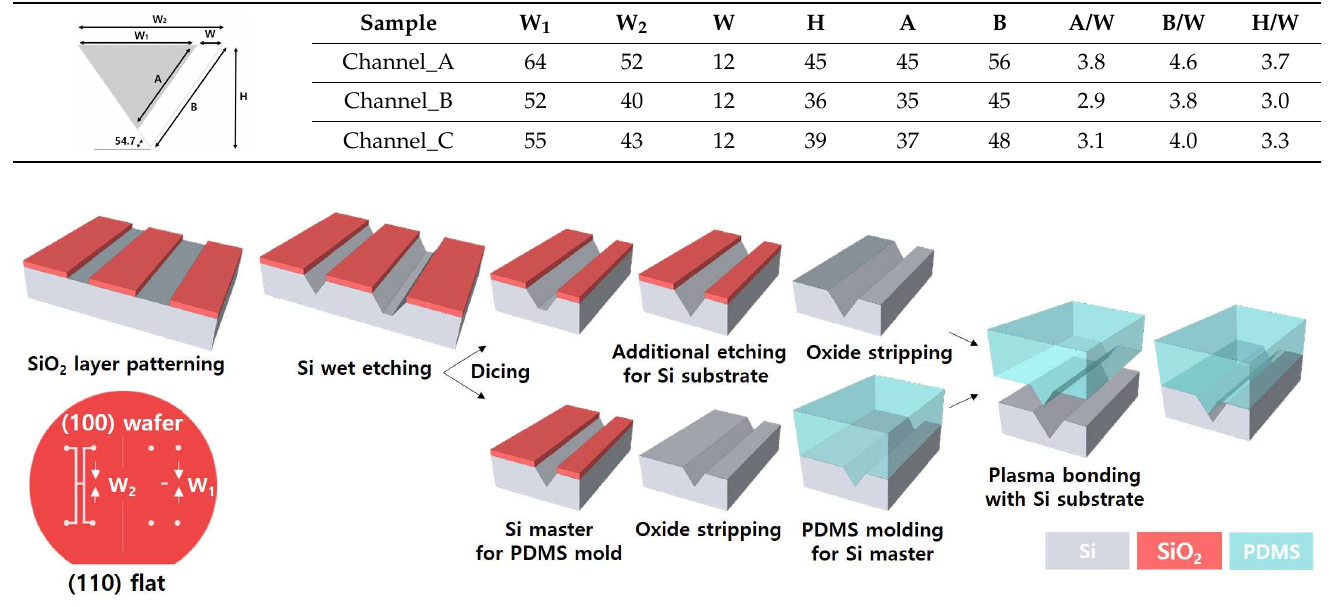
Figure 1. ( a ) Schematic view of the developed microfluidic device comprising a middle interconnect- ing channel with an asymmetric cross-section in the T-junction region, ( b ) Design parameters for the HTWR trapezoidal channel with the asymmetric cross-section. Figure 2. Fabrication process of the microfluidic devices with the asymmetric channel. Table 1. Design parameters of the microfluidic channels with asymmetric cross-sections.